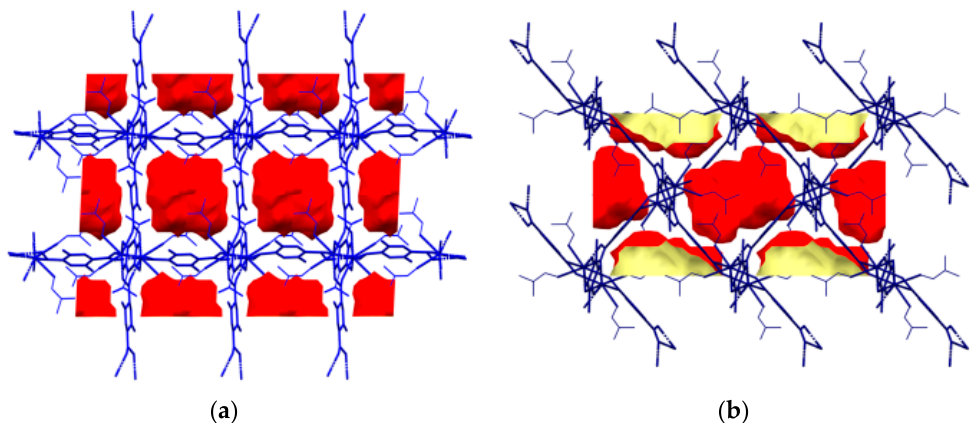
Figure 7. The voids in crystal packing of 2 along the ( 001 ) vector ( a ) and 3 along the ( 100 ) vector ( b ). The voids volumes were computed with probe radius 1.2 Å and approx. grid spacing 0.7 Å. Color code: the outer side of the voids, red; the inner side, yellow.